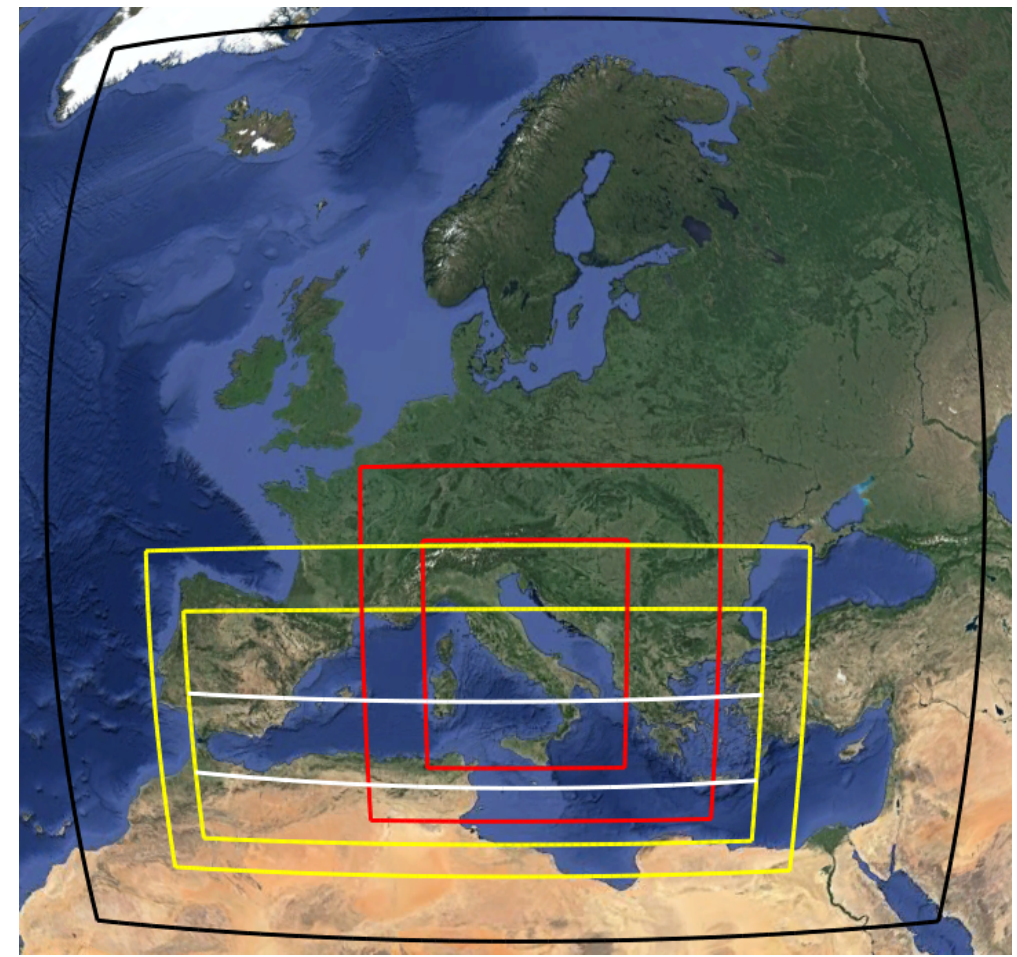
Figure 2. The largest modeling domain (black) and examples of the nested grids, for 2003 in yellow and for 2005 in red, displayed in Google TM Earth. The two horizontal white lines in the smallest 2003 domain are the cross-sections at roughly 34 and 39 ◦ N described in Section 4.4. See Figures S2–S6 for all model